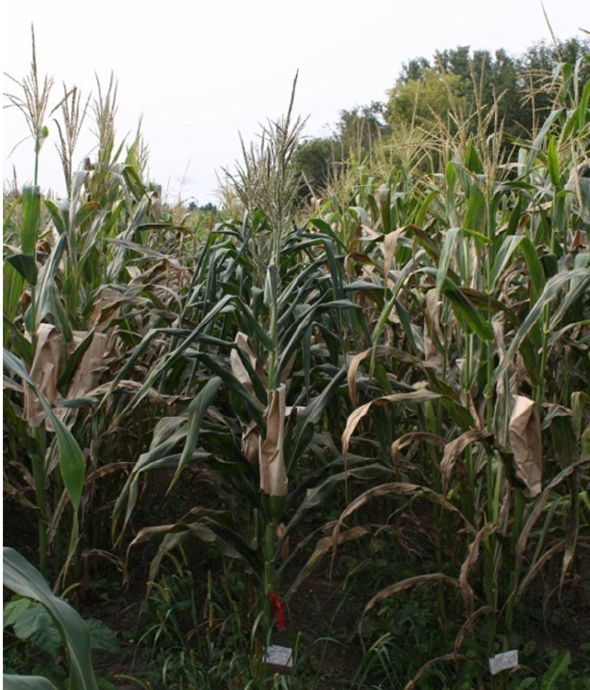
Figure 11: Derivatives of the ‘C’ family grown on a N limited sites after rye near Elkhorn, WI in 2016. On the left side of this picture are various C6 subfamily inbred lines. On the right side are various C4-6 subfamily breeding lines Comparisons of advanced sister breeding lines that trait was associated with earlier flowering, and better ear